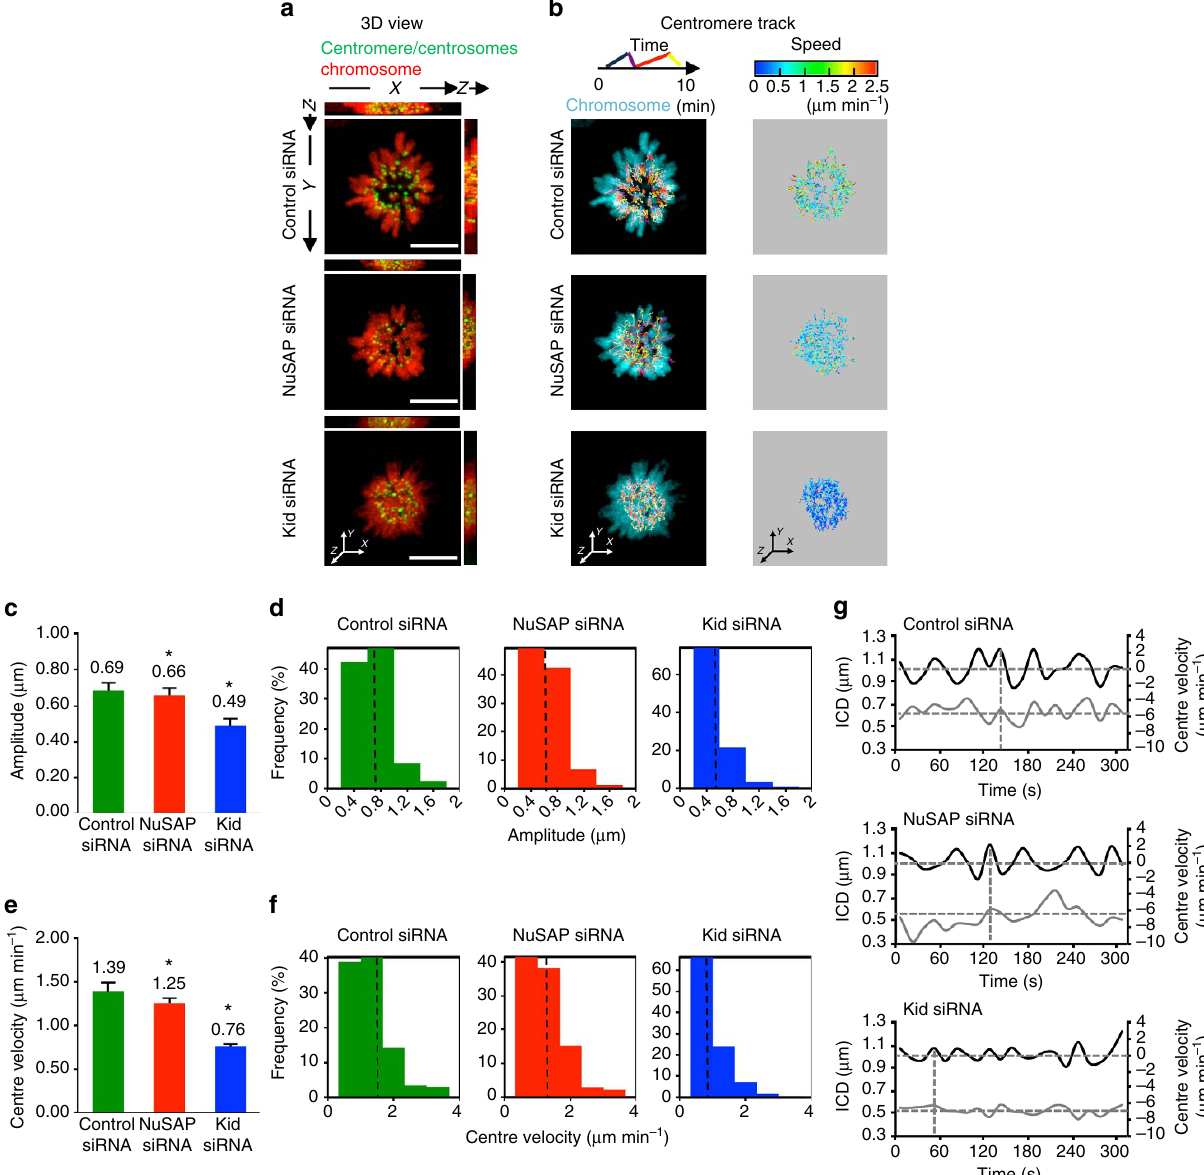
Figure 5 | The effects of NuSAP and Kid depletion on the amplitude and velocity of centromere oscillation in monopolar cells are correlated. ( a ) Representative images of the 3D view using xz and yz projections in the control, NuSAP- or Kid-depleted monastrol-treated monopolar HeLa cells stably expressing mCherry-H2B. Centromeres were marked with GFP-CENPA and centrosomes with GFP-centrin. Scale bar, 5 m m. ( b ) Representative images of the 3D centromere tracks colour-coded for time and velocity. ( c , d ) Bar chart and histogram representing the average ( c ) and the distribution ( d ) of the amplitude of centromere oscillation in the control, NuSAP- or Kid-depleted monopolar cells. Error bars represent þ s.e.m. * P o 0.001, by t -test. ( e , f ) Bar chart and histogram representing the average ( e ) and the distribution ( f ) of the centre velocity. Error bars represent þ s.e.m. * P o 0.001, by t -test. ( g ) Representative velocity (black line) and ICD (grey line) versus time plots of the projected centre in a sister centromere pair in the control, NuSAP- or Kid-depleted monopolar cells. The sign of the velocity indicates the direction of centromere movement. The average of the ICD (horizontal) and the minimum (horizontal) and maximum velocities (vertical) are indicated by the dashed